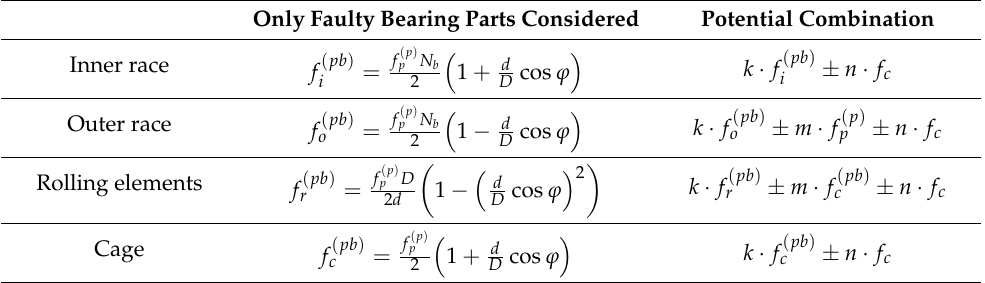
Table 7. Fault characteristic frequency of planet bearing.